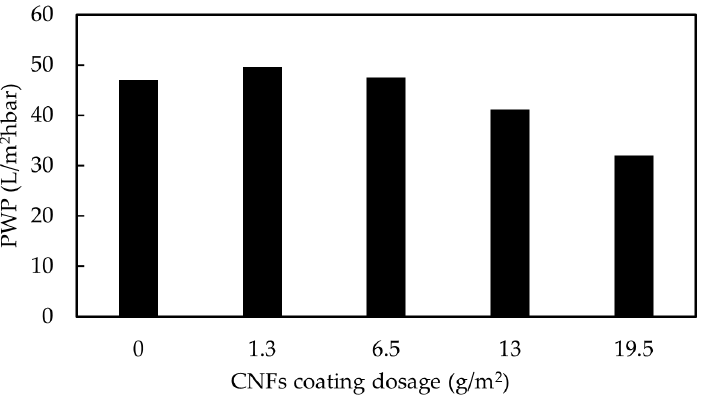
Figure 4. Pure water permeability of pristine and coated UF membranes at different CNFs dos- ages.